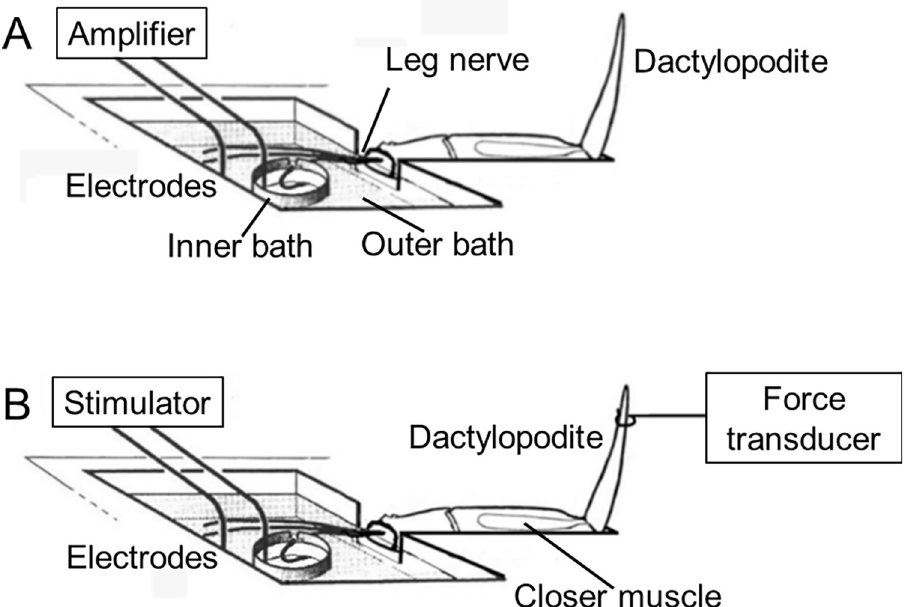
Fig 2. Experimental arrangements. (A) Recording from the nerve of an isolated C . pagurus leg. (B) Stimulating the crab leg nerve while recording the forces produced by the dactylopodite closer muscle.